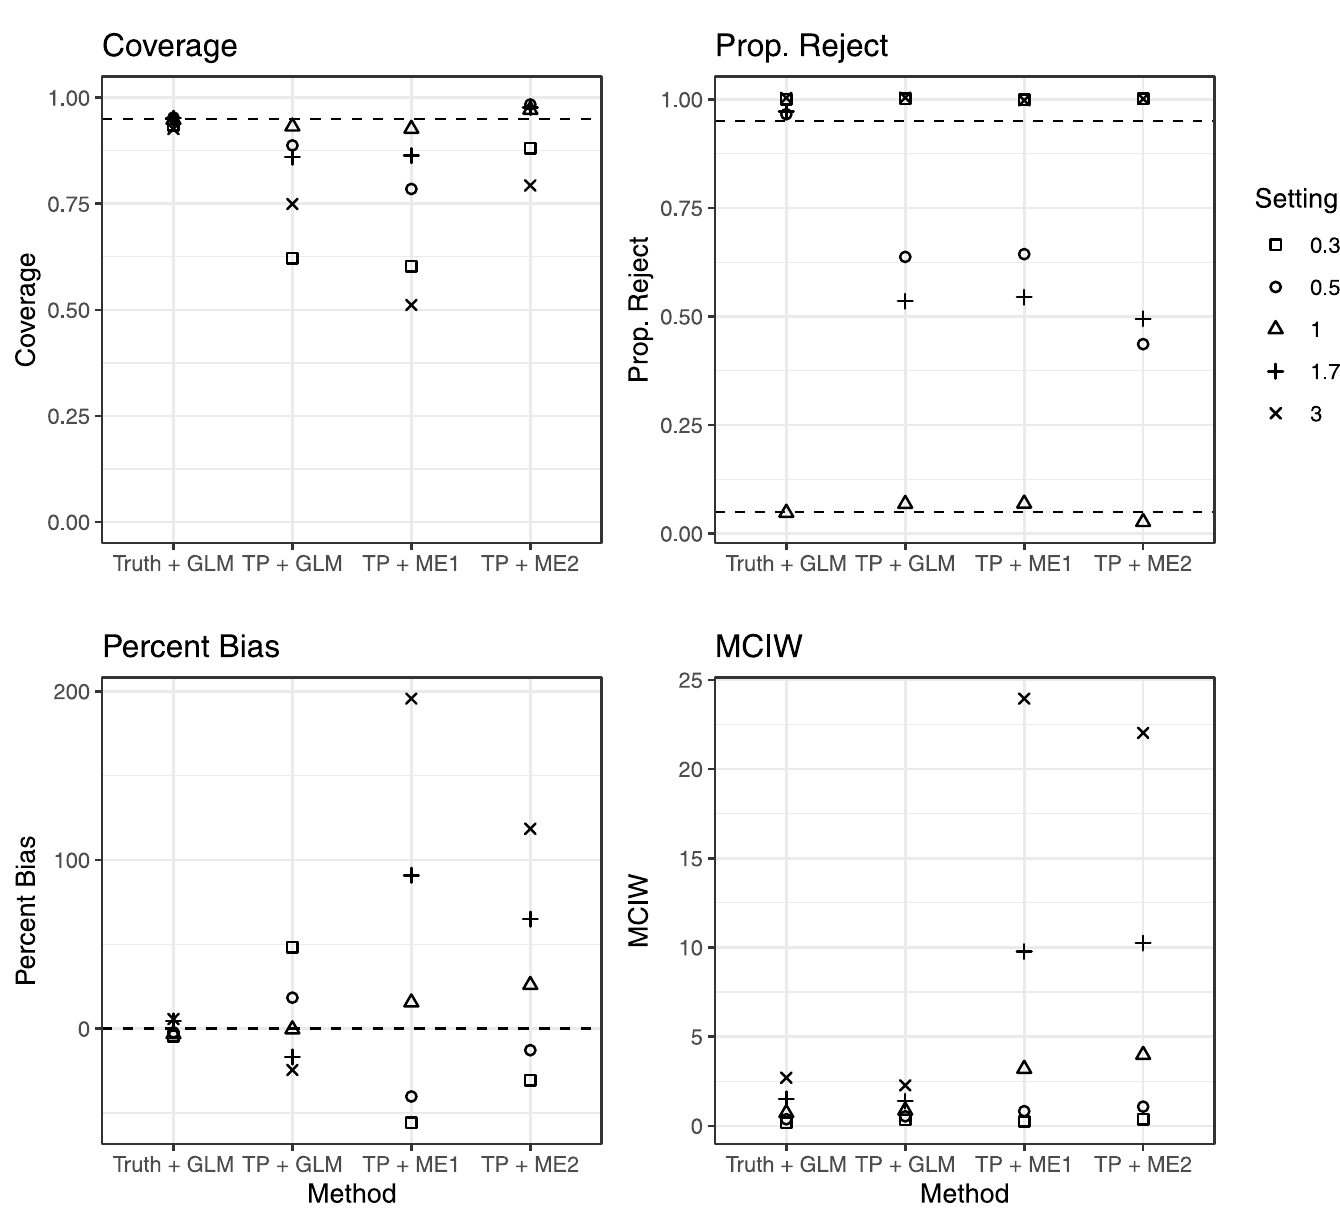
Fig 2. Operating characteristics of statistical pipelines in primary simulation settings. Truth + GLM is a reference pipeline where the true infection source labels are used as response variables in a generalized linear model. TP + GLM is a pipeline where infection source labels generated by TransPhylo are used as response variables in a generalized linear model. TP + ME1 is a pipeline where infection source labels are generated by TransPhylo and used as an input into a model from the SAMBA package, which allows for false positives. TP + ME2 again uses labels generated by TransPhylo as response variables into a model which allows for both false positives and false negatives. The settings denote different simulation settings, each value describes the true ratio of the probability of transmission given contact for cases living without HIV to cases with HIV. I.E., 0.57 means that the probability of transmission given contact for hosts without HIV was 1.75 times as small as the probability of transmission given contact for hosts with HIV. Coverage refers to proportion of simulations where 95% confidence intervals captured the true odds ratio. Prop. Reject refers to the proportion of simulations where a null hypothesis that the true odds ratio was one would be rejected, assuming significance level of 5%. Percent bias is bias divided by the true odds ratio, MCIW is mean confidence interval